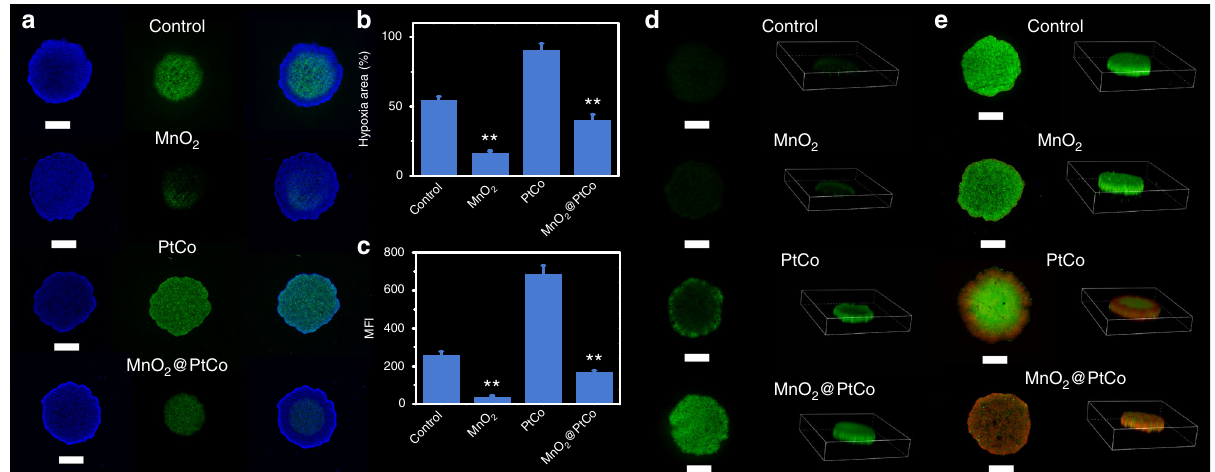
Fig. 5 The ability of MnO 2 @PtCo nano fl owers on mitigating hypoxia, generating ROS and cytotoxicity in MCTS. a The hypoxia evaluation of 4T1 MCTS at 24 h after various treatments. Hypoxia was assessed by staining with HIF-1 α (green) and DAPI (blue). b The quanti fi cation of hypoxia areas was performed with Image J. c Flow cytometric analysis of fl uorescence intensity of HIF-1 α in MCTS after various treatments. d Detection of nanozymes-induced ROS in MCTS. e LIVE/DEAD staining of MCTS with Calcein-AM (green) and PI (red) at 24 h after different treatments. Scale bars are 500 μ m. Asterisks indicate signi fi cant differences ( * P < 0.01, ** P < 0.005, *** P < 0.001), analyzed by unpaired Student ’ s two-sided t test. Data were presented as mean ± s.d. ( n =